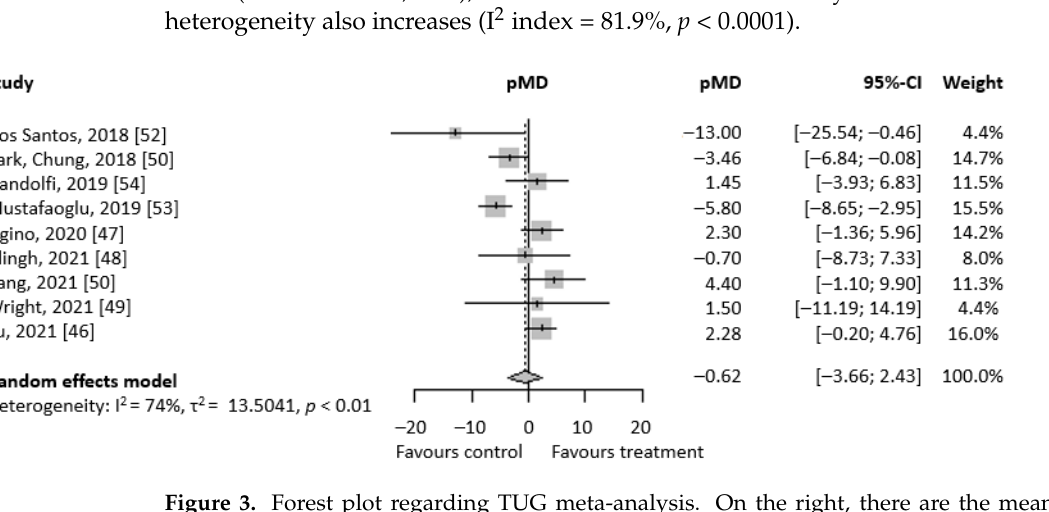
Figure 3. Forest plot regarding TUG meta-analysis. On the right, there are the mean pre-post difference of each selected study and their respective 95% CI. At the bottom, written in bold, there are total pMD, its 95% CI, and heterogeneity evaluation.